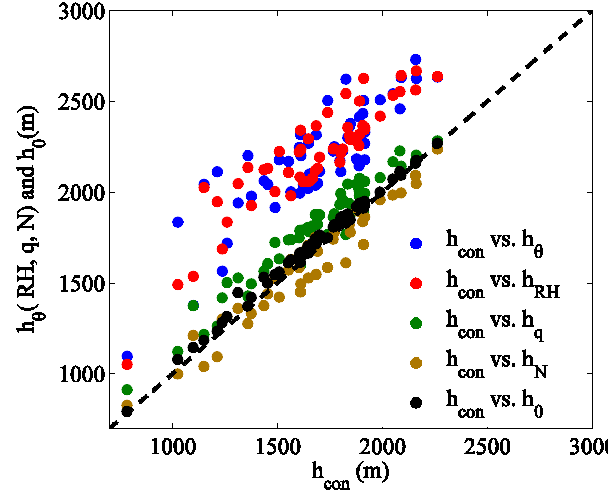
Figure 6. The comparison of the climatological h con with h θ (blue), h RH (red), h q 534 Figure 6. Comparison of the climatological h con with h θ (blue), h RH (red), h q (green), h N (brown) and h 0 (black) for the period (green), h N (brown) and h 0 (black) for the period of 1998 to 2008. 535